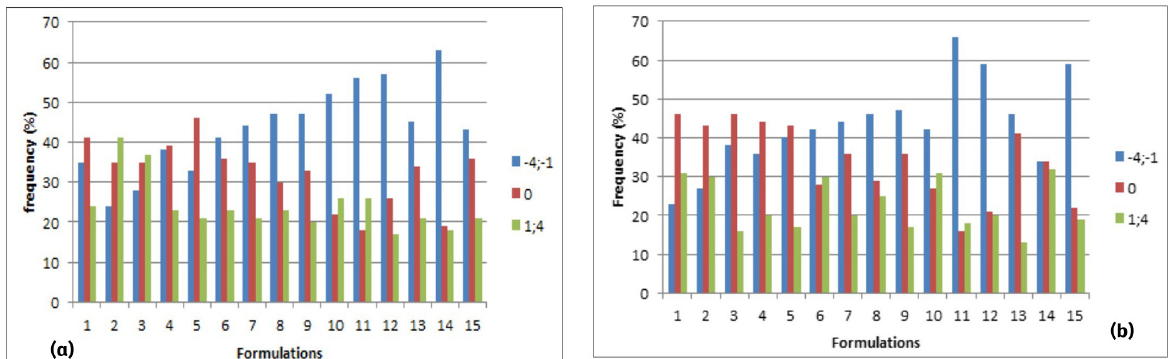
Figure 2. Histograms of sweetness (a) and consistency (b) ideals of different banana preserves formulations. * Formulation 15: average of the values obtained by formulations 15, 16, 17 and 18. (-4;-1 = less sweet/consistent than ideal, 0 = ideal, and 1;4 = sweeter/consistent than ideal).